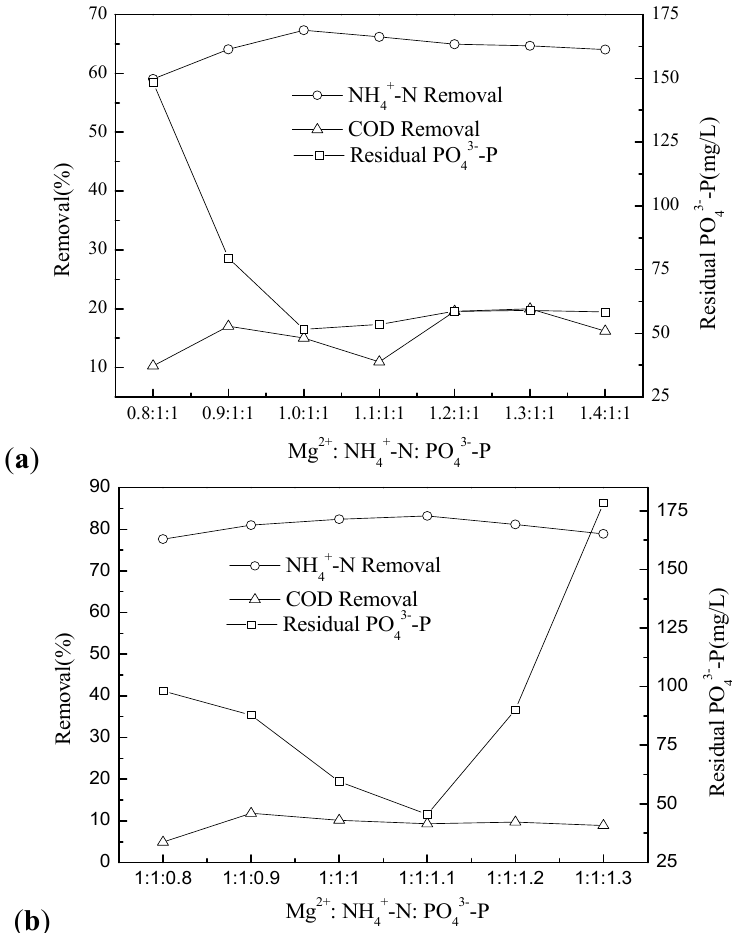
Figure 6. Effect of the mole ratio of Mg 2+ :NH 4+ -N:PO 43 − -P on the removal of NH 4+ -N and the residual phosphate at pH 9.0 and mixing time 15 min, the molar ratio range